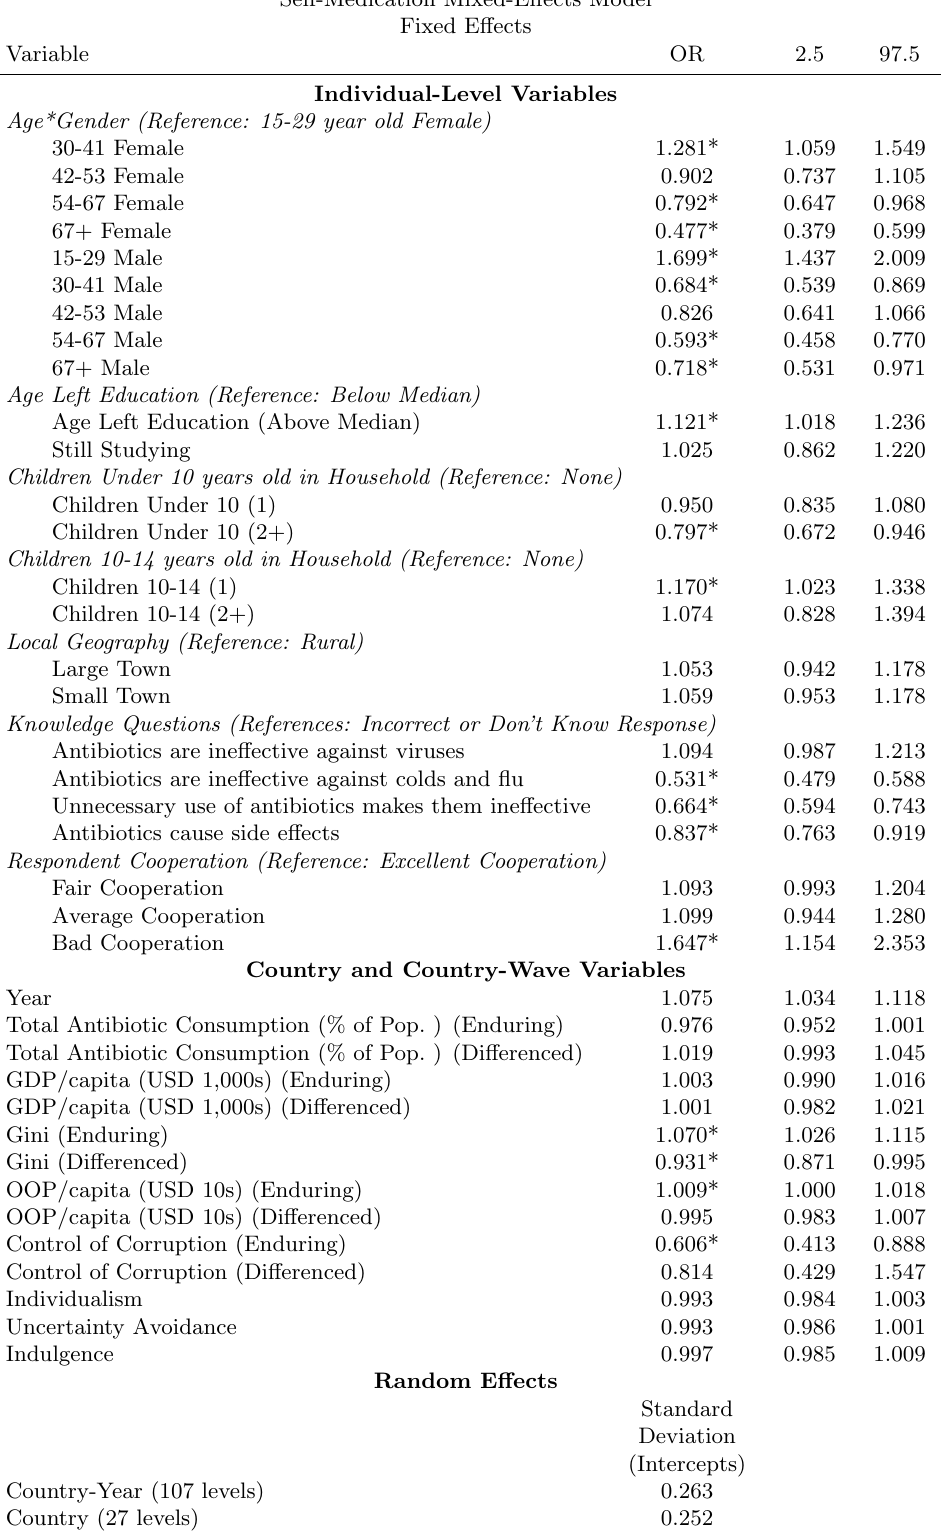
Table 3: Results for full mixed-effects logistic regression model predicting whether an antibiotic consumer self-medicated or obtained antibiotics through a